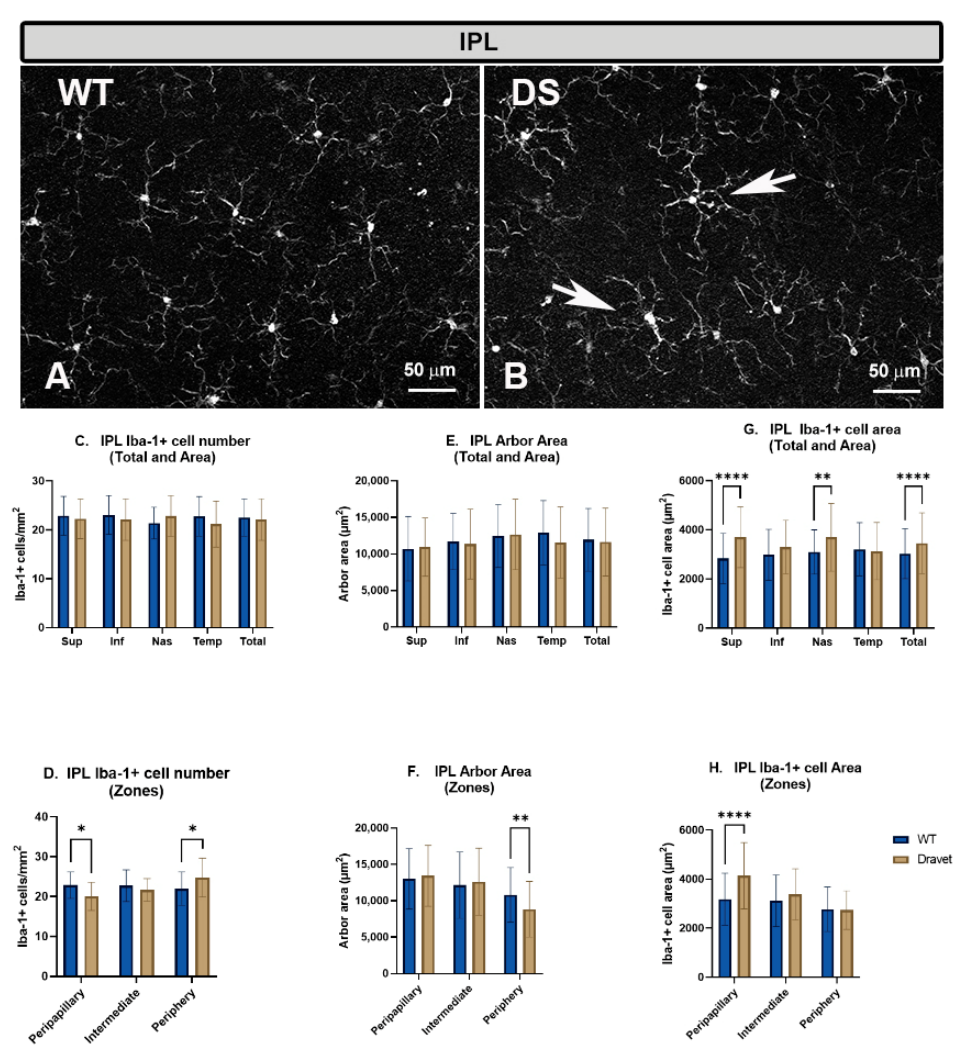
Figure 2. Microglial cells in the inner plexiform layer (IPL). ( A , B ): retinal whole-mounts labeled with anti-Iba-1 at 20 × magnification. Arrows indicate Iba-1+ microglial cells with robust appearance in the Dravet syndrome (DS) animals. ( C , D ): number of Iba-1+ microglial cells per retinal area 0.1502 mm 2 by total retina and area ( C ) and by zone ( D ). ( E , F ): Arbor area of Iba-1+ microglia by total retina and area ( E ) and by zone ( F ). ( G , H ): Iba-1+ cell area by total retina and area ( G ) and by zone ( H ). Two-way ANOVA. Data expressed as mean value ( ± SD). * p < 0.05, ** p < 0.01, **** p < 0.0001. Number of retinas used in the experiment: WT animals n = 6, DS animals n = 6. Sup: superior; Inf: inferior; Nas: nasal; Temp: